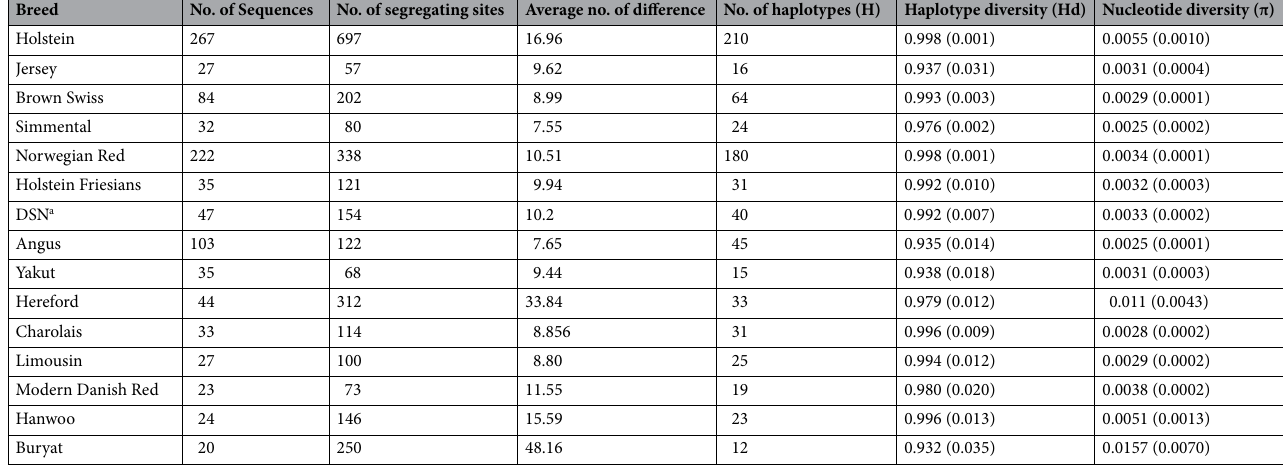
Table 7. Mitochondrial DNA sequence polymorphism and diversity (standard deviation) of selected breeds with a sample size of 20 or more. a DSN Deutsches Schwarzbuntes Niederungsrind.